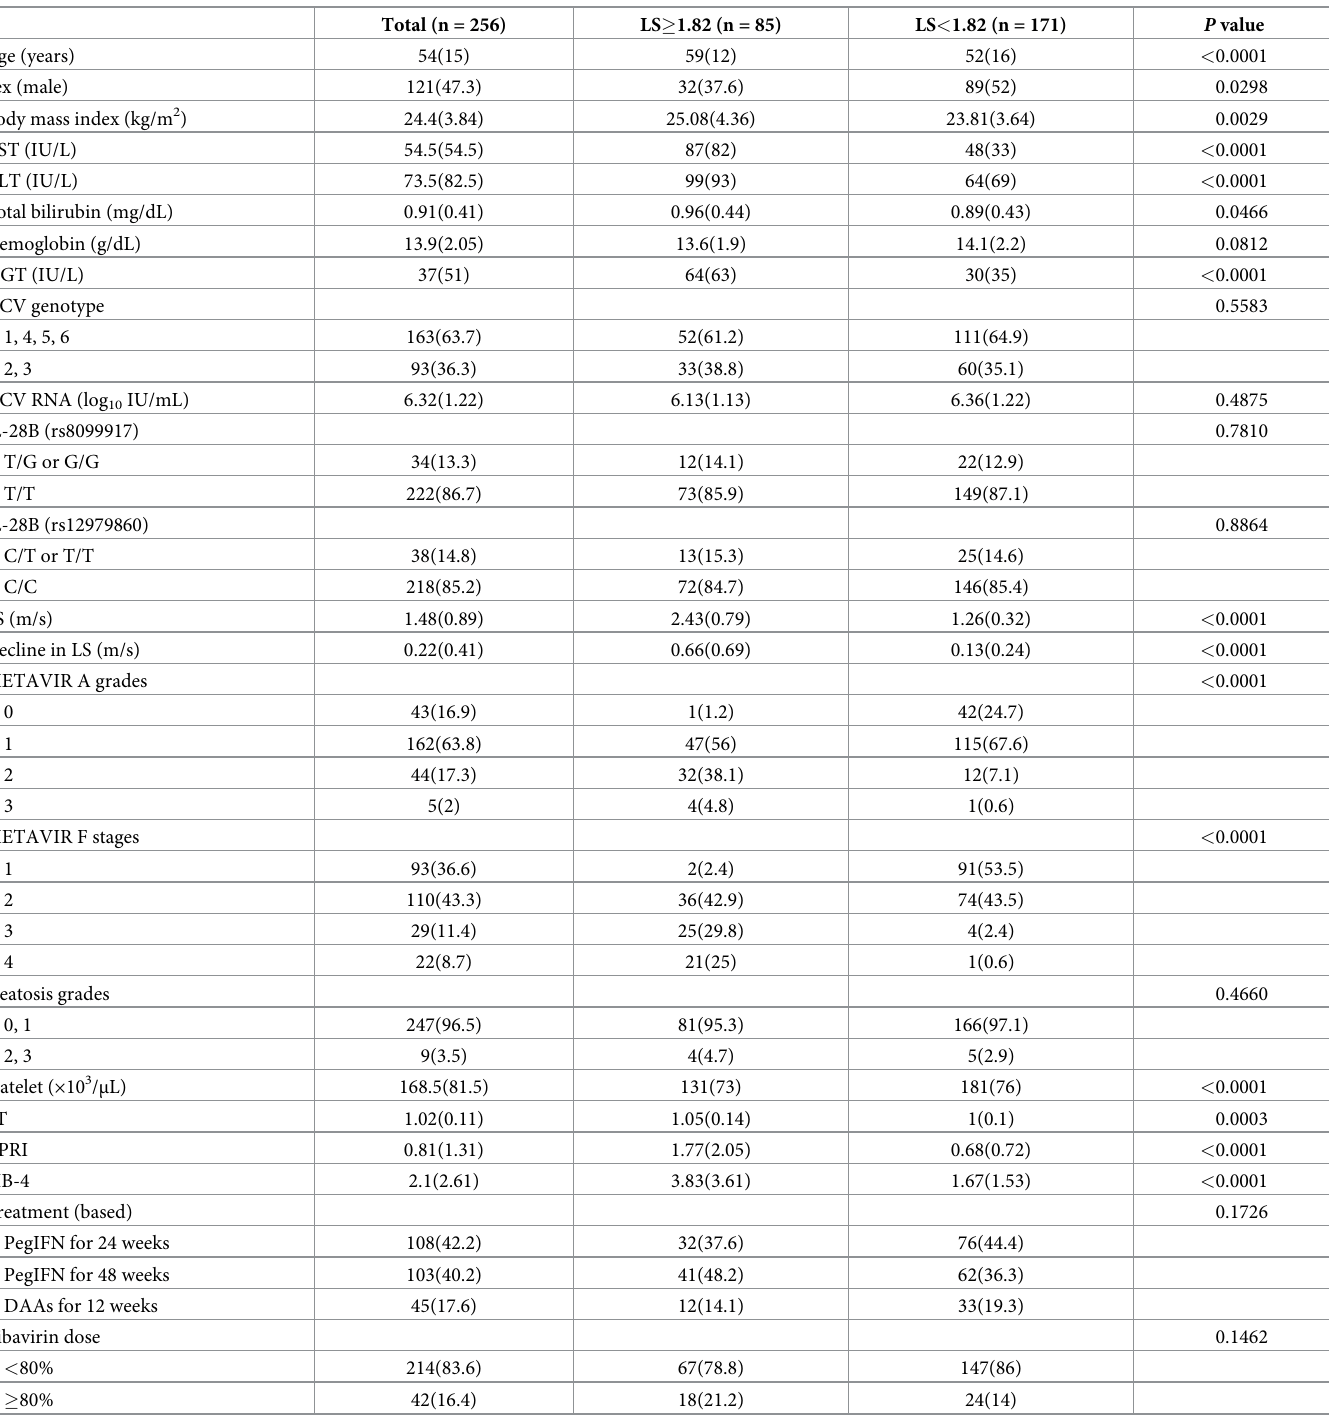
Table 1. Comparisons of patient characteristics between groups with baseline liver stiffness of (cid:21) 1.82 and < 1.82